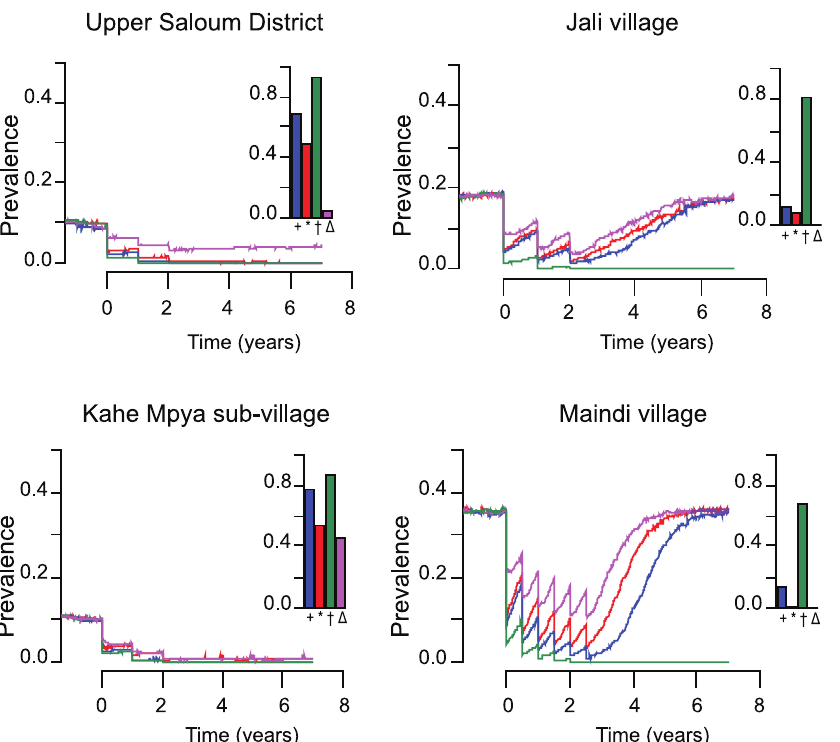
Figure 1. Comparison of MDA with HTT or MDA of children , 10 years old only. The y-axis represents prevalence of ocular C. trachomatis infection. Blue ( + ) – MDA with 80% coverage, Red (*) – HTT with 80% coverage, Green ( { ) – HTT with 100% coverage, Purple ( D ) – MDA of children under the age of 10 years old with 80% coverage. Treatment rounds commence at time=0. Upper Saloum district, Kahe Mpya sub-village and Jali village have three annual treatment rounds, Maindi village has six biannual rounds because of the high baseline prevalence of infection. 100 stochastic simulations were run for each scenario and the median of these simulations at each time point are displayed here. The bar charts show the probability of eliminating infection from the community for each treatment scenario. MDA=Mass drug administration. HTT=Household targeted treatment.